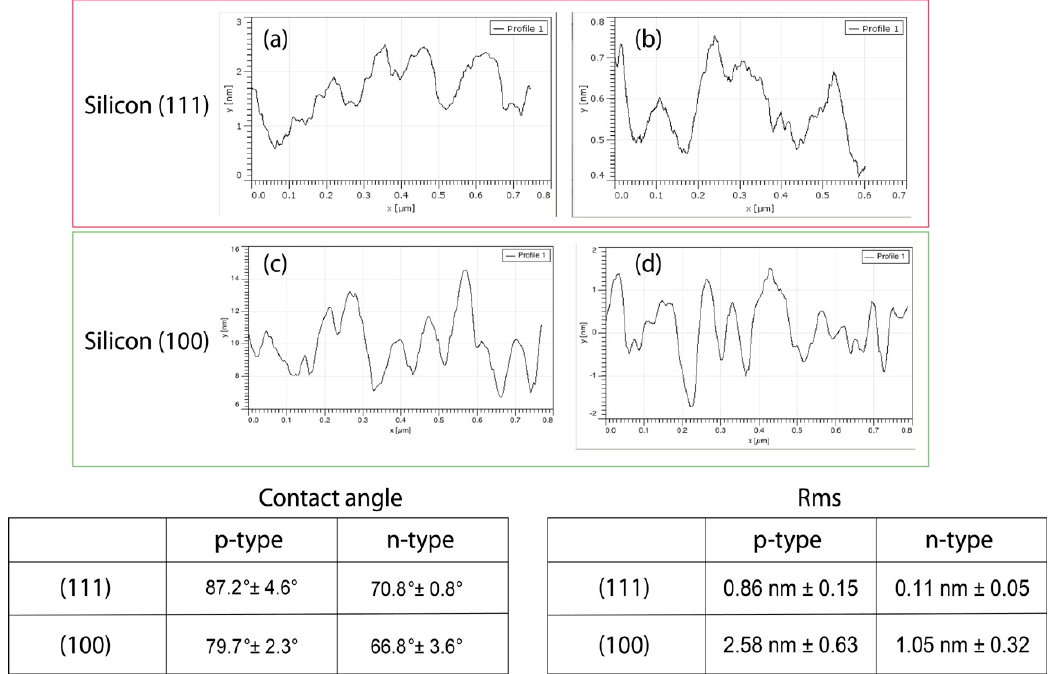
Figure 4. Roughness profile of silicon (111) after grafting for ( a ) p -type and ( b ) n -type while the profile for silicon (100) was also displayed for ( c ) p -type and ( d ) n -type.